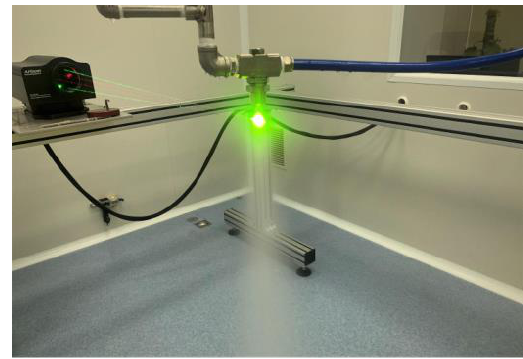
Figure 8. PDI test in working condition.